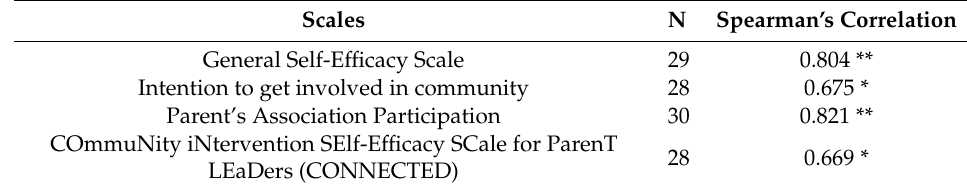
Table 3. Temporary stability (intraclass correlation coe ffi